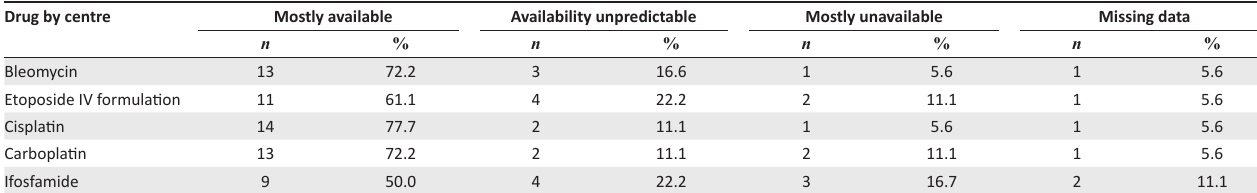
TABLE 5: Availability of chemotherapy drugs ( n = 18). Drug by